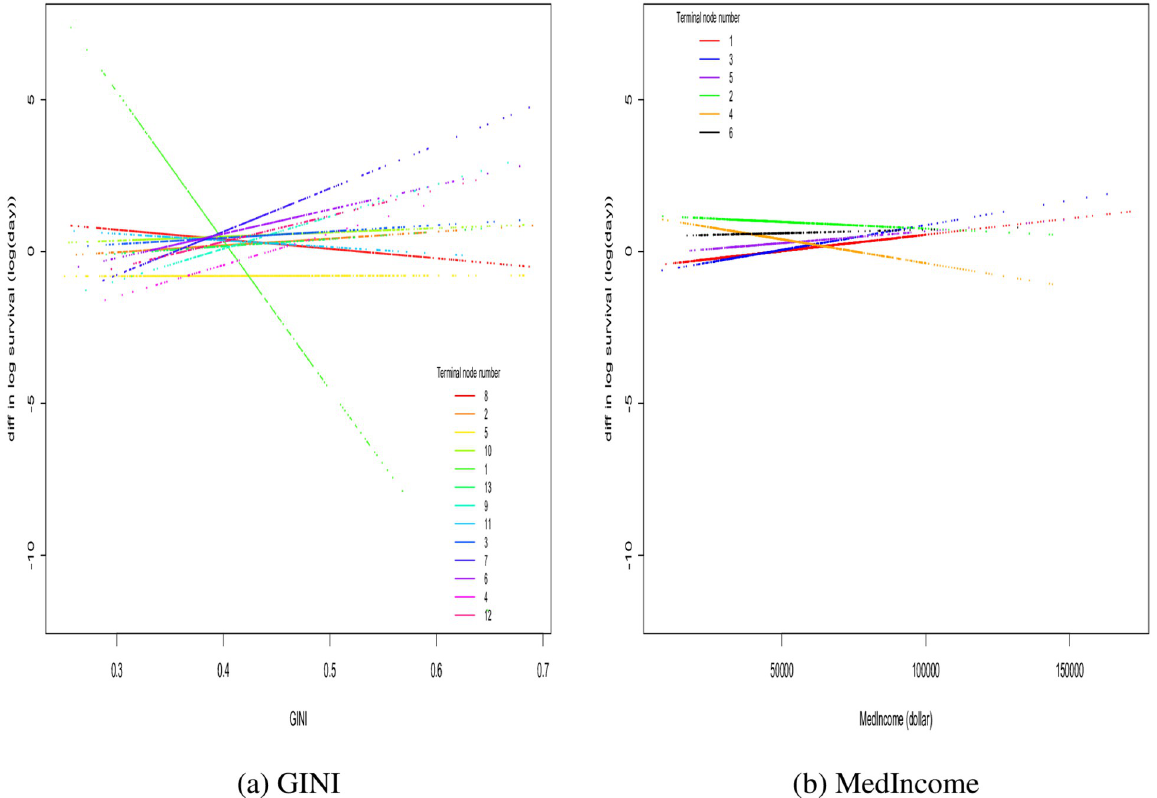
Fig 4. HPRISM hierarchical moderation plots for GINI and MedIncome. Each colored represents a different terminal node (defined by the individual level variables) in the HPRISM tree. The y-axis plots mean difference in log survival between Whites and Blacks at given values of the social determinant. Hierarchical moderation is visible as follows: at the level of individual variables because the y-axis values do not overlap at fixed x-values; at the level of the social determinant, when the lines are not parallel. Notice though for MedIncome, the lines are nearly parallel. (a) GINI. (b) MedIncome.